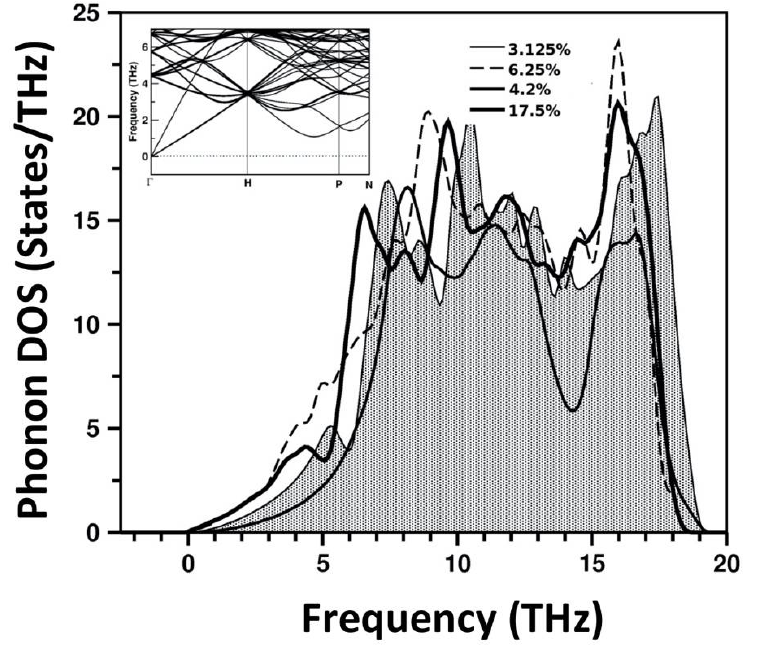
Figure 2. DFT calculated phonon DOS at 364 GPa for Fe-Ni alloy with varied Ni concentrations. The Ni atoms were carefully distributed in a random fashion in the bcc Fe matrix. Inset shows the phonon band structure of the 3.125% Ni-containing case.